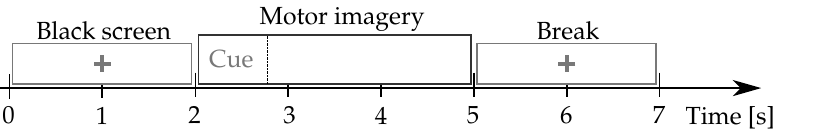
Figure 1. Dolutegravir may inhibit HIV-resistant viruses from becoming archived within the vi- ral reservoir.